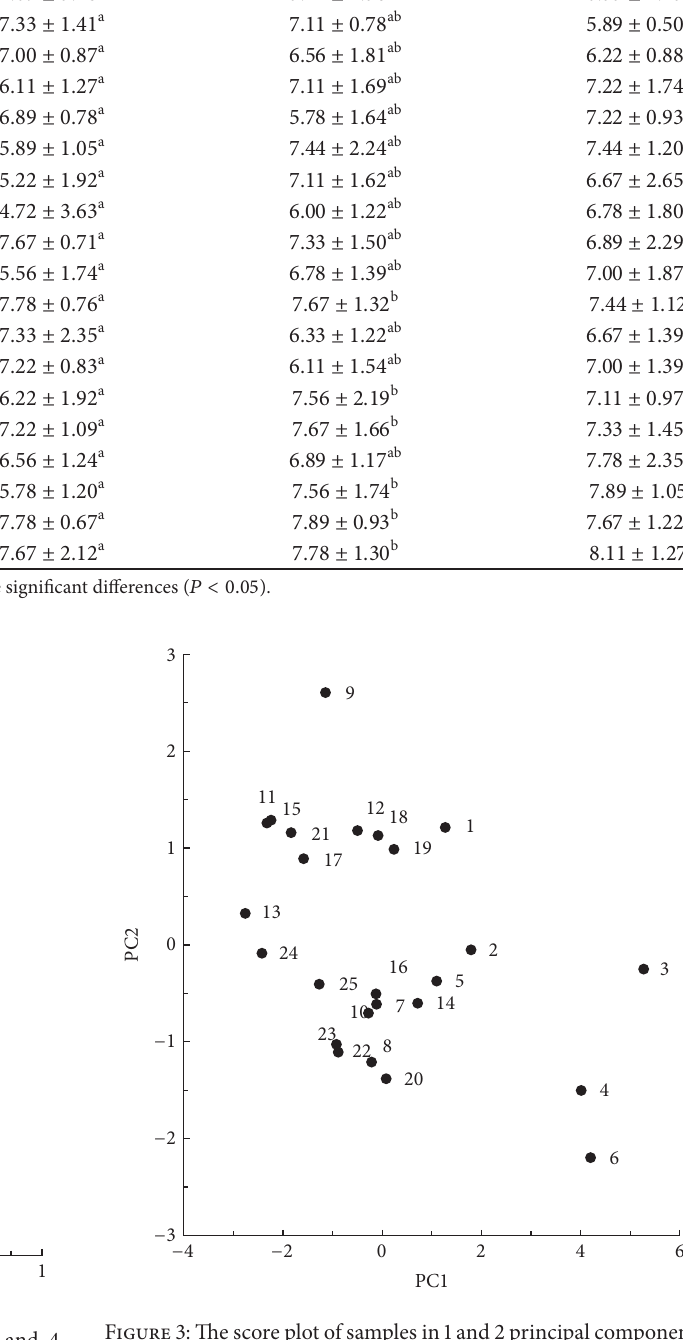
Figure 2: The loading plot of term of fried fritters in 3 and 4 principal components (PC3 and PC4).